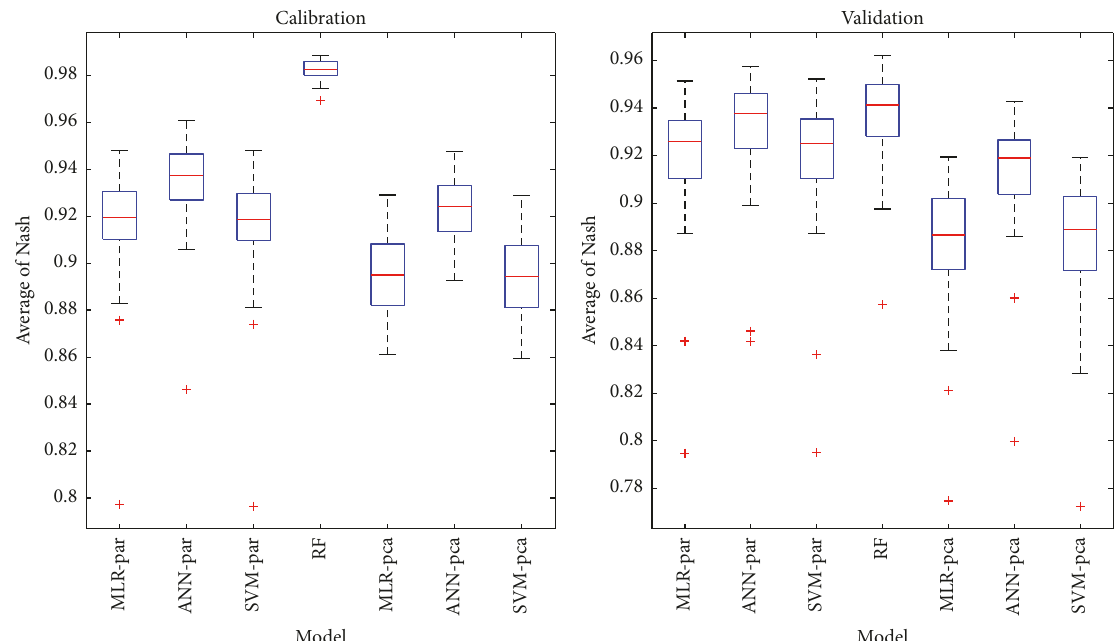
Figure 8: Average Nash in calibration and validation period for all models.